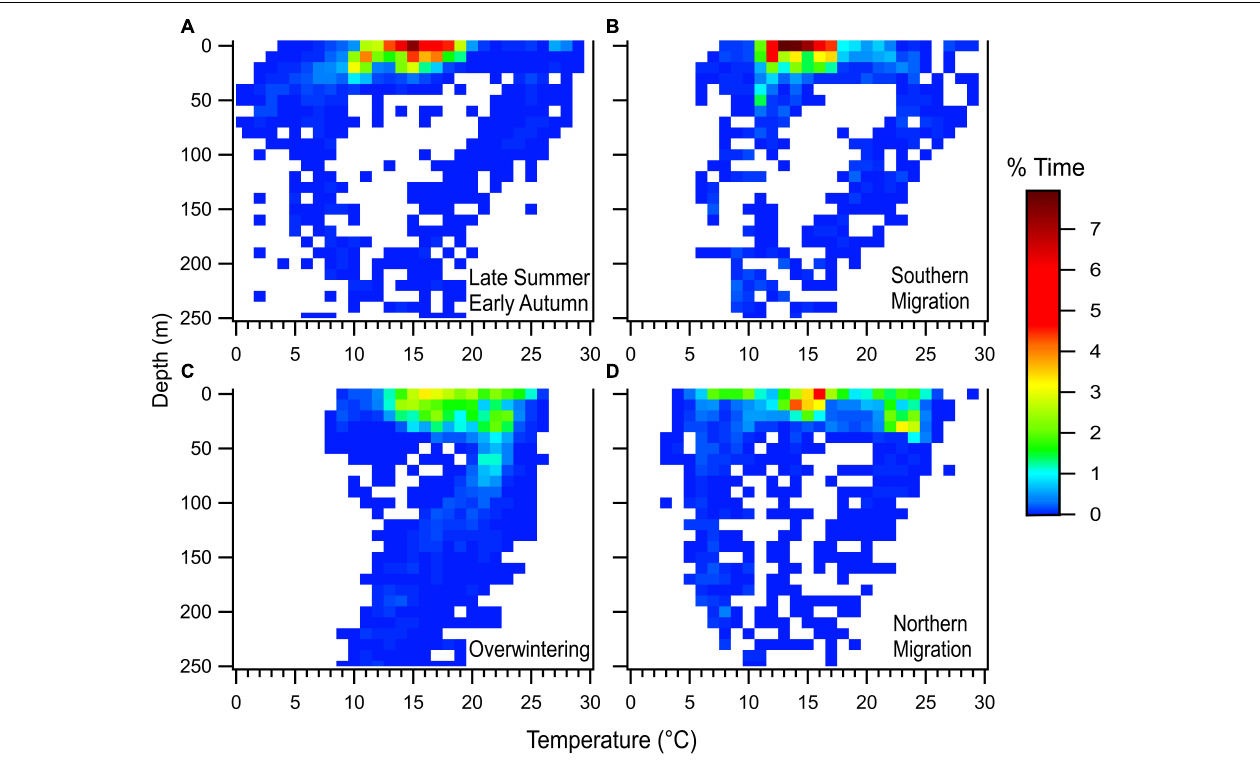
FIGURE 8 | Aggregated temperature-at-depth profile from time series data of four PSAT-tagged white sharks demonstrating vertical habitat utilization across seasons. (A) Late summer/early autumn. (B) Southern migration. (C) Overwintering. (D) Northern migration. While depth data did extend below 250 m, this represented < 1% of overall time, thus for clarity, y -axes represent time between 0 and 250 m